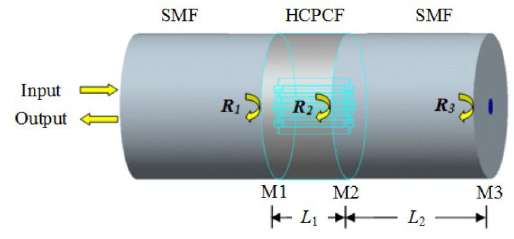
Fig. 1 Structure of the proposed FPI based on HCPCF.